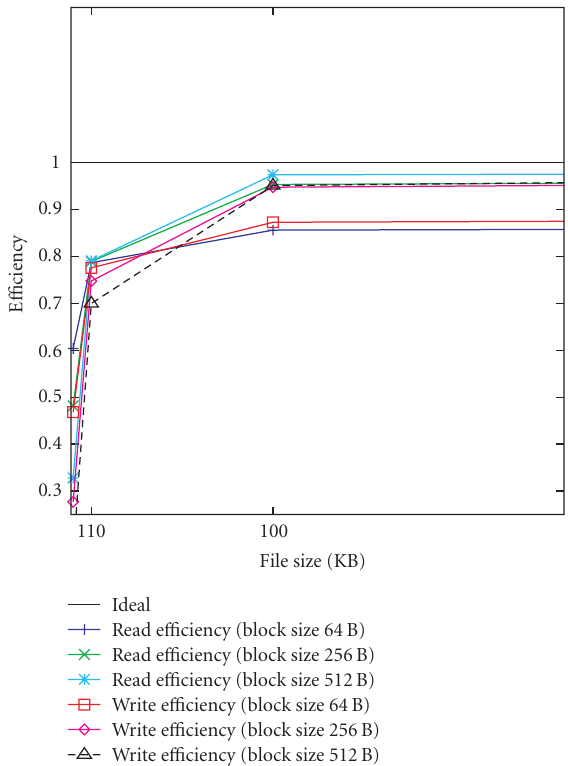
Figure 13: HWFS sequential read/write e ffi ciency in simulation plotted against di ff erent file